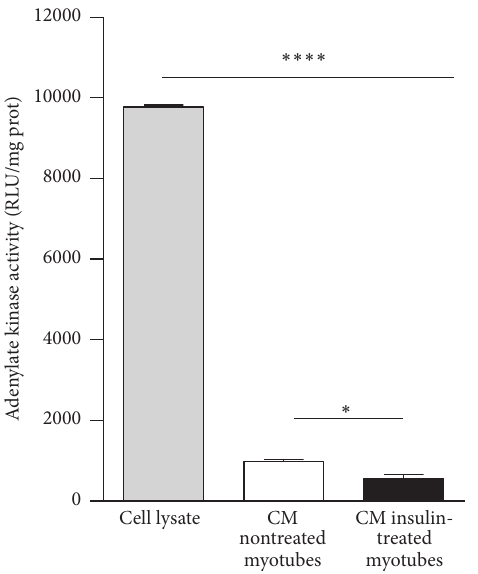
Figure 2: Myotube death in conditioned media from noninsulin- and insulin-treated myotubes. Cell death was assessed by chemi- luminescent quantification of adenylate kinase activity normalized to total protein content. RLU, relative light units. Mean ± SEM. ∗ 𝑝 < 0.05 and ∗∗∗∗ 𝑝 < 0.000 1, one-way ANOVA with Tukey post hoc test.